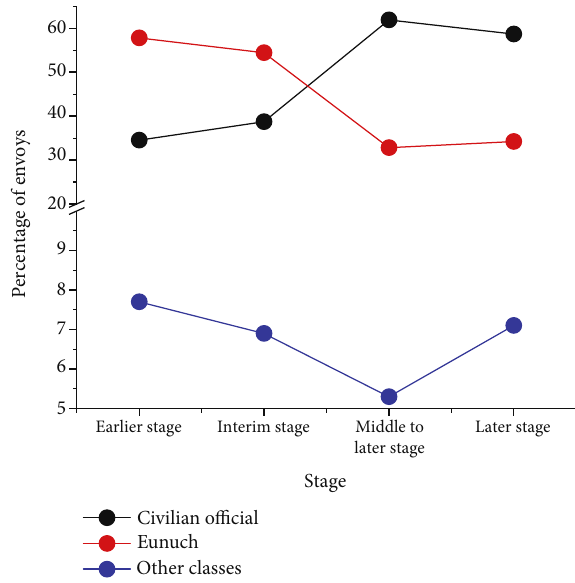
Figure 6: The status of the Ming Dynasty envoy to Korea in di ff erent